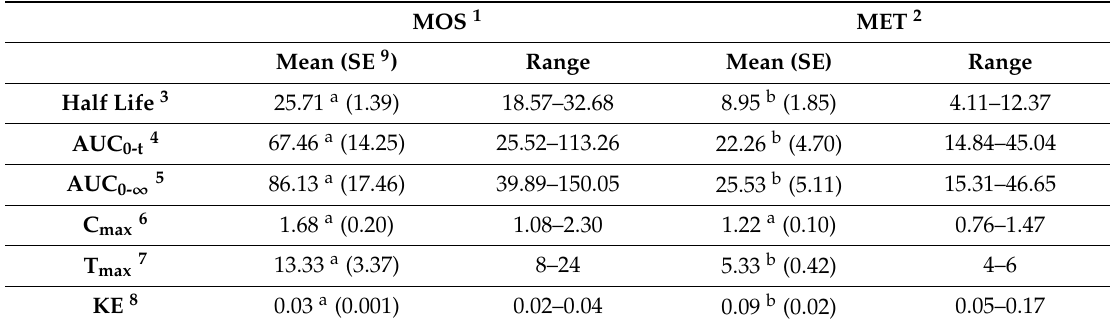
Table 2. Pharmacokinetic parameters of plasma meloxicam in oral- and subcutaneously-treated cows.